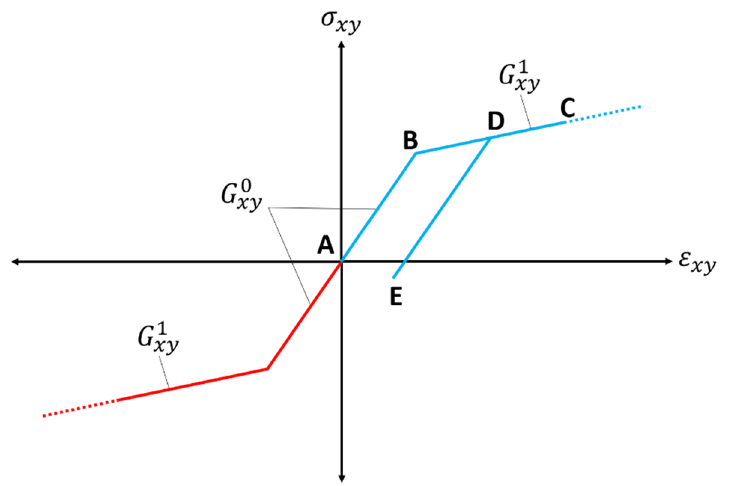
Figure 12. Shear characteristic in Abaqus.